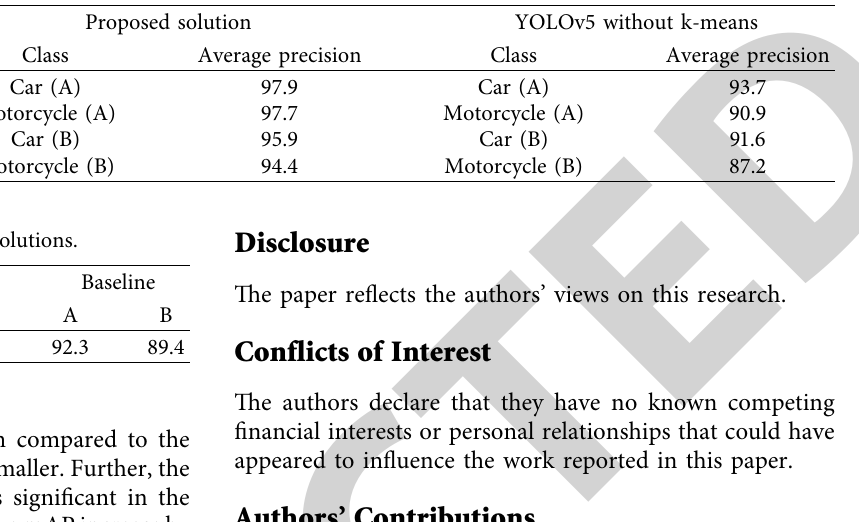
Table 4: Results comparison of proposed, baseline, and benchmark paper.